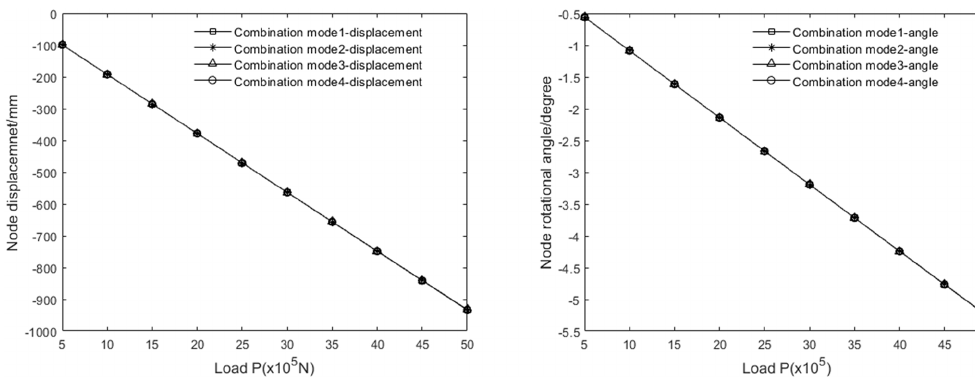
Figure 12. Load–displacement relationship of right end node.